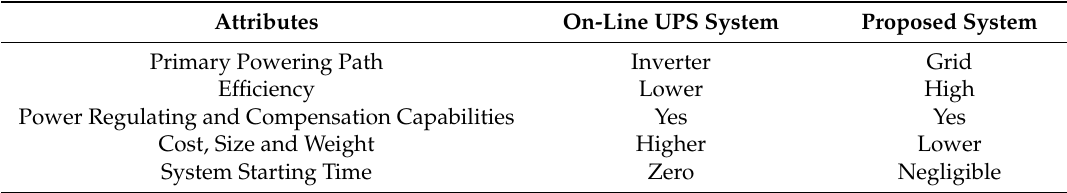
Table 2. Comparison of the proposed fault correction technique and an online UPS system.